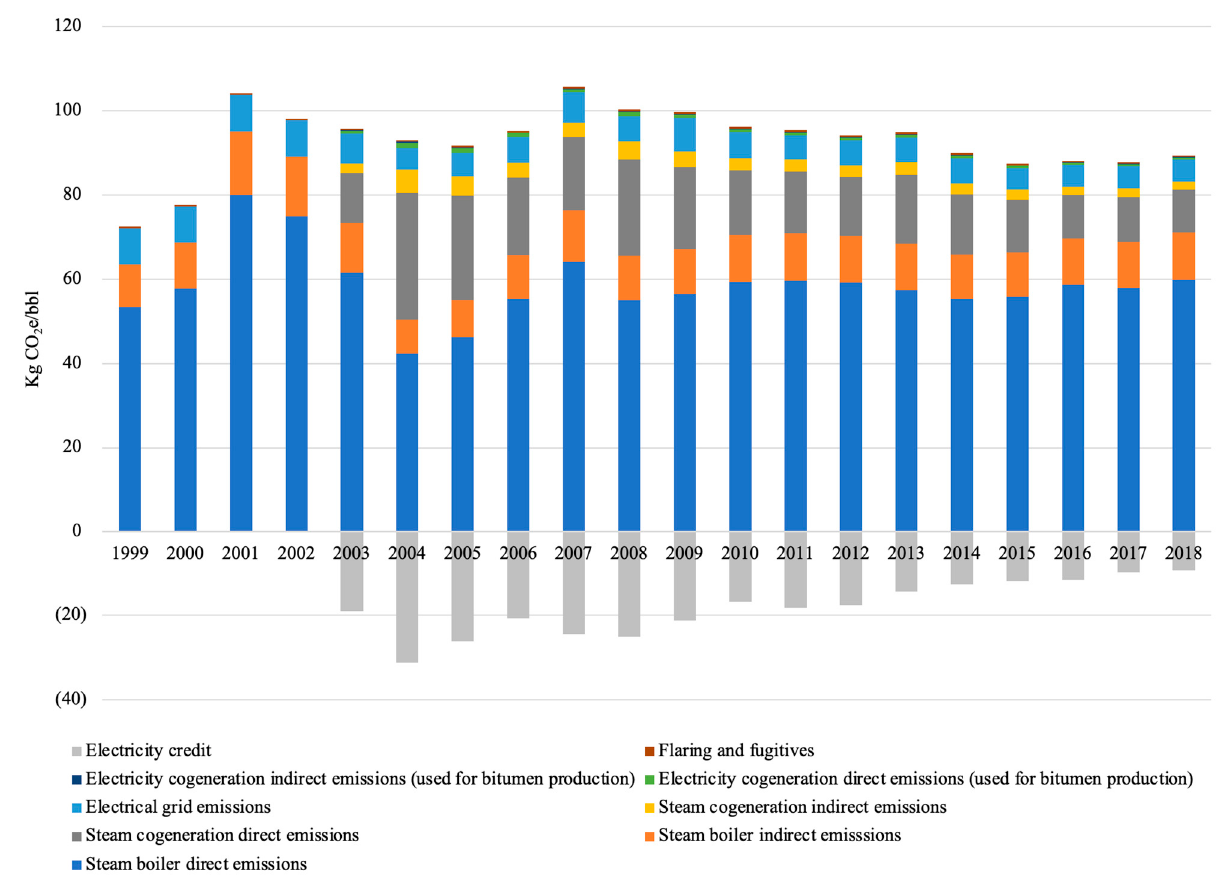
in cSOR (3.21 in 2007 to 2.75 in 2018). The results are the same in terms of direct relation- ship between cSOR and emissions intensity in Cases 2 and 3. Figure 4. Case 3—GHG emissions intensity of SAGD operations per year (with electricity credit).